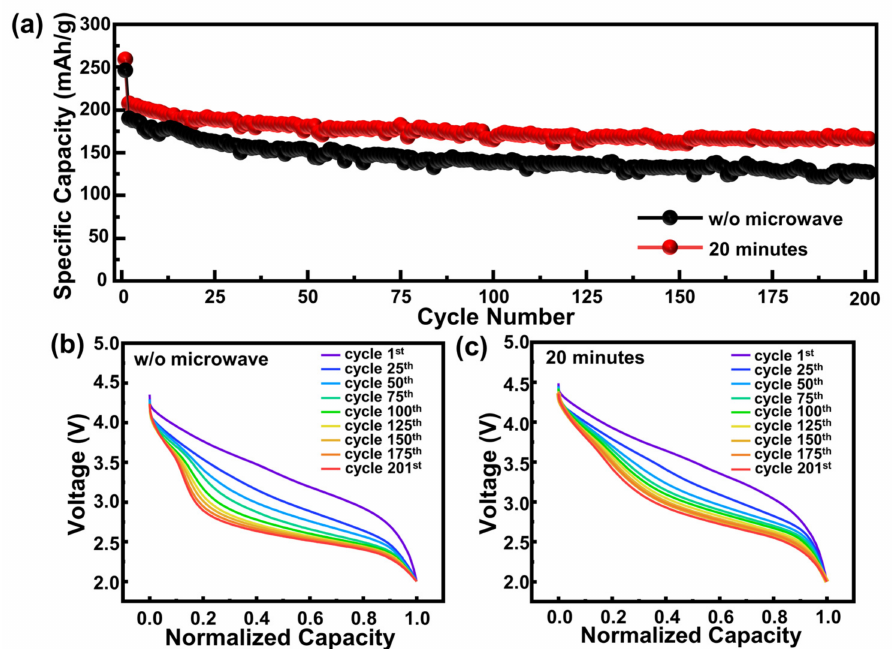
Figure 6. ( a ) Long-term cycling stability test of LNCM samples without and with 20 min of microwave treatment, and selected voltage discharge profiles of LNCM samples ( b ) without microwave treatment and ( c ) with 20 min of microwave